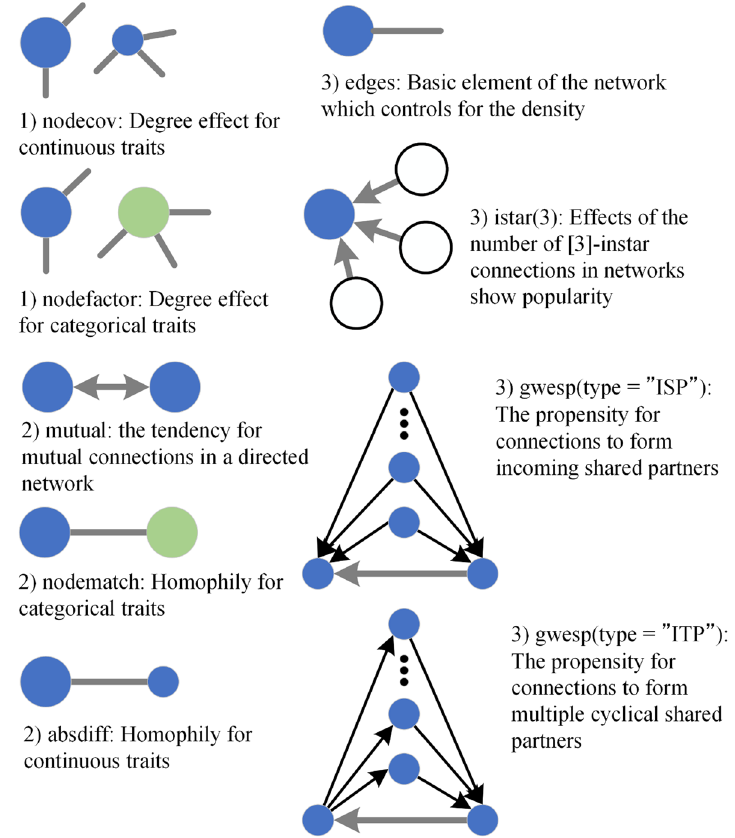
Fig. 1 Diagrammatic guide to key terms used for this study. The number at the top of each term denotes the related covariate: 1, node-based; 2, dyadic; 3,